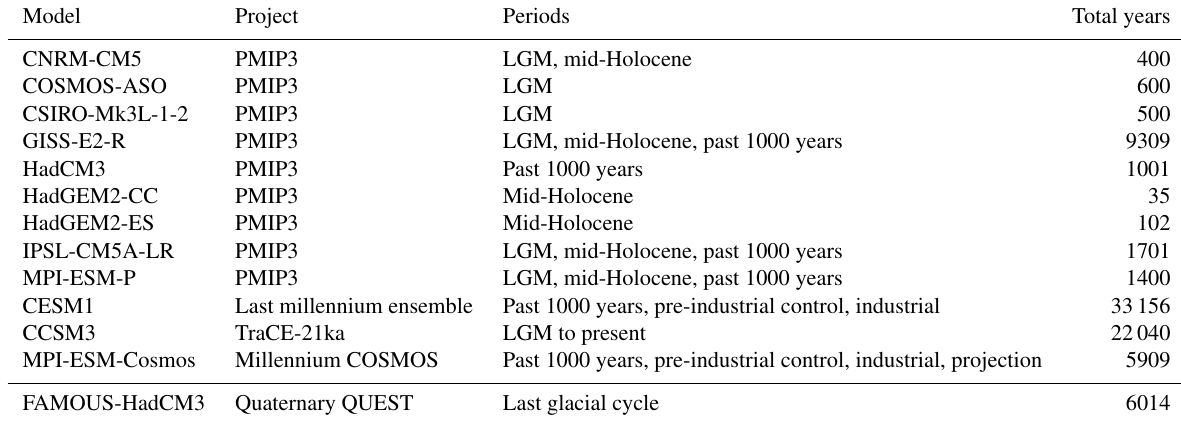
Table 2. Information about the pool of simulation data: model name, the project for which the simulations were performed, the simulated periods from this model output, the number of total years. All simulation data are remapped to 0.5 by 0.5 ◦ grids. References and data locations are provided in Appendix Table A2. The Appendix also lists all individual simulations used in Table A3. Note FAMOUS-HadCM3 uses accelerated forcings. We thus chose to exclude this simulation for most